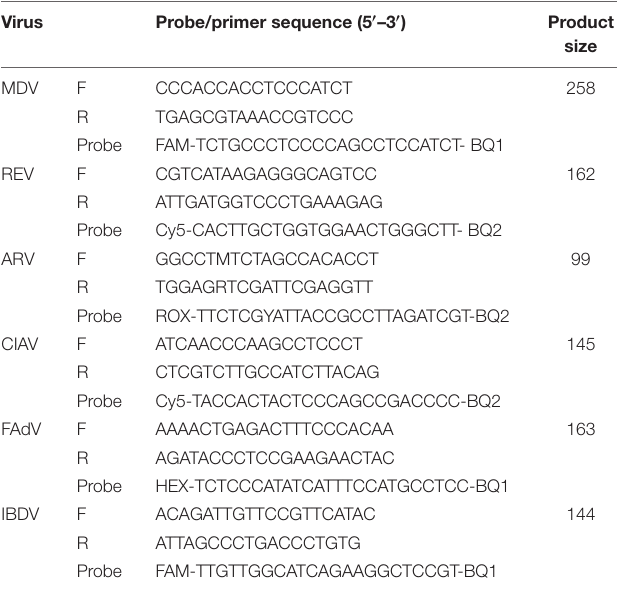
TABLE 2 | Primers and probes used in the MRT-qPCR assay.